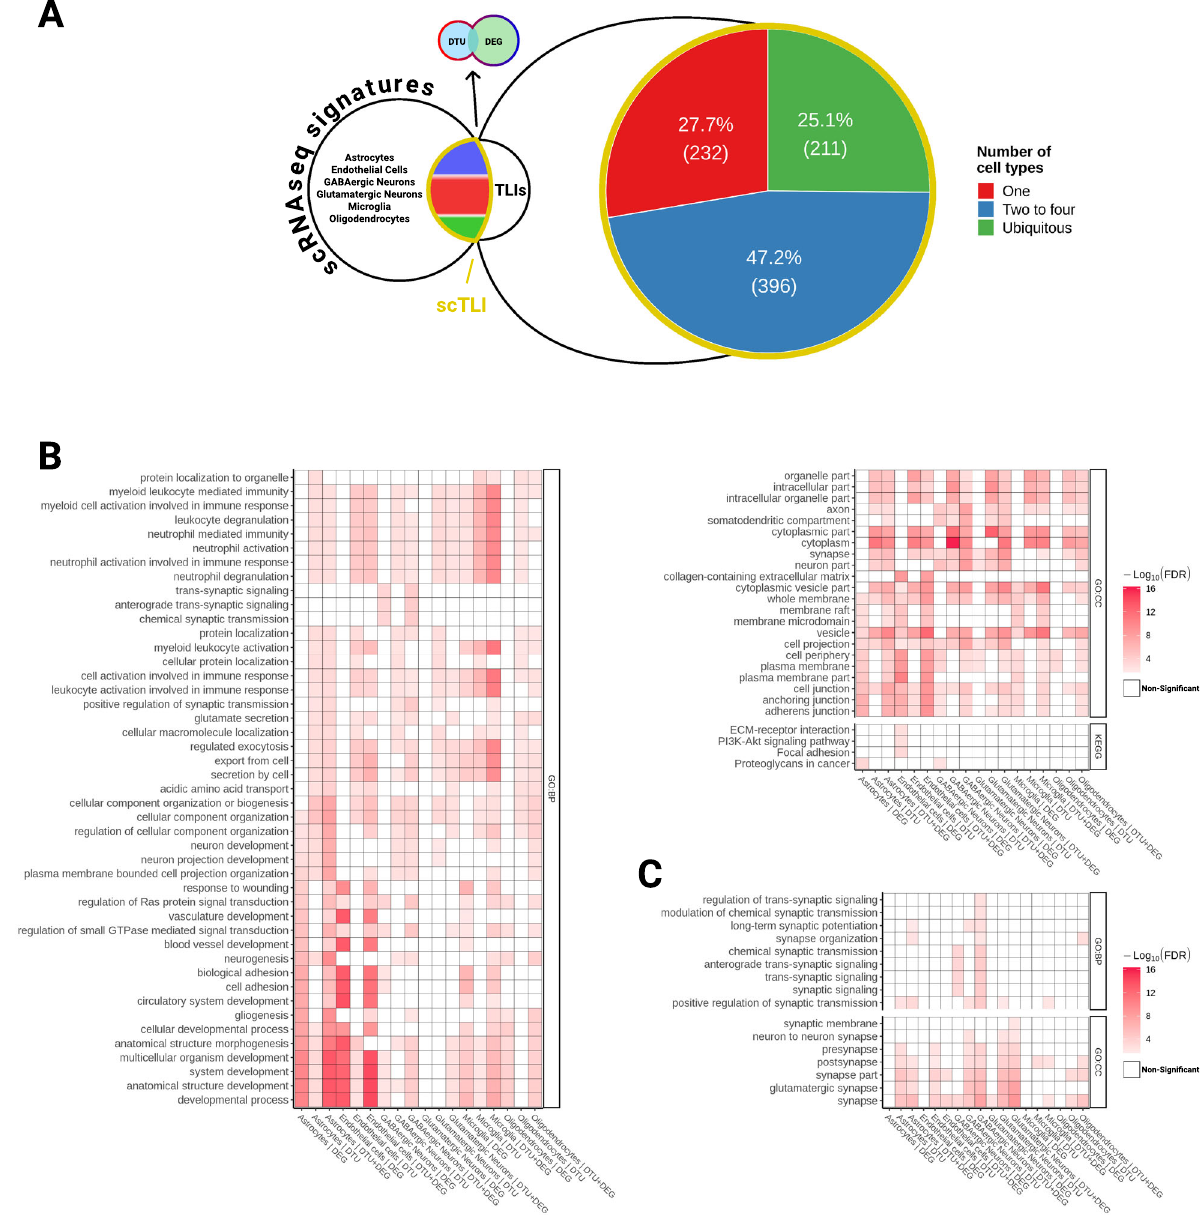
Fig. 7 Cell-type expression pattern for genes altered in AD brains. A Schematic representation showing our strategy to assign DEGs and gDTUs identi fi ed in the TLI to speci fi c cell types of the adult human brain (see also Supplementary Fig. 1). Out of 839 single-cell TLI genes (scTLI), 281 were expressed in a unique cell-type, 249 in 2 – 4 cell-types, and 77 in all cell-types/subtypes analyzed. B Gene ontology terms enriched for scTLI DEGs, gDTUs, or both per cell type. C Selected GO terms associated with synaptic